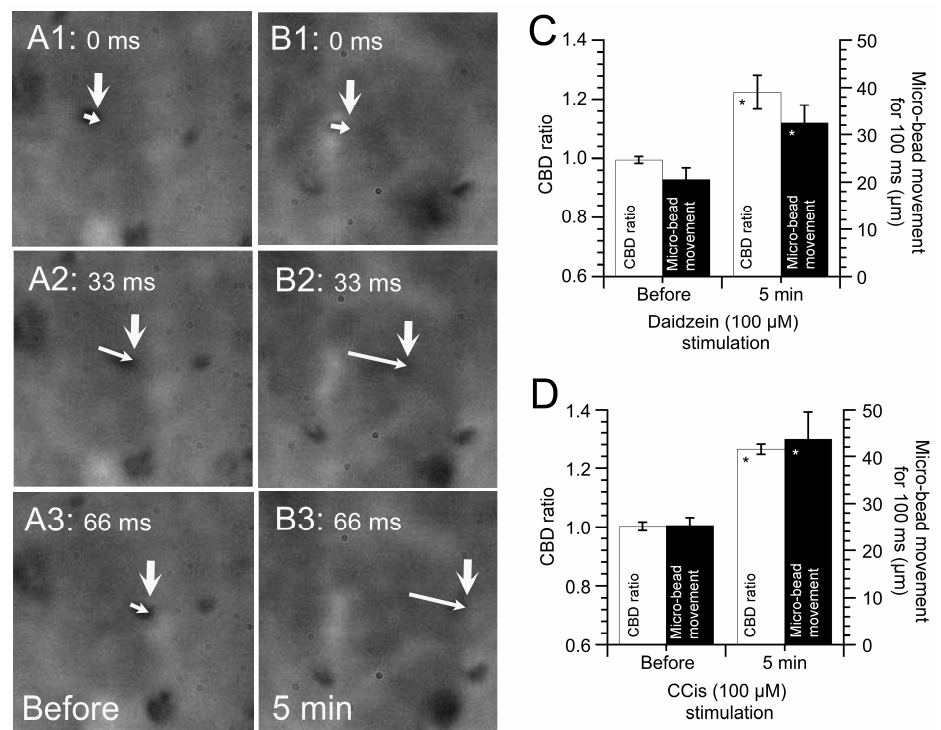
Figure 6. Latex microbead movement driven by ciliated human nasal epithelial cells. Panels A and B show six consecutive images recorded every 33 ms. ( A ) Before daidzein addition. ( B ) Five min after daidzein (100 µ M) addition. The large arrows indicate the initial position of a microbead, and the small arrows indicate the distance that the microbead has moved. Daidzein stimulation enhanced microbead movement. ( C ) Daidzein-induced enhancement of ciliary beat distance (CBD) and microbead movement. Daidzein stimulation enhanced CBD and microbead movements. ( D ) Carbocisteine (CCis)-induced enhancement of CBD and microbead movements. CCis stimulation enhanced CBD and microbead movements. * indicates results significantly different from the control values ( p < 0.05). Error bars indicate SE.